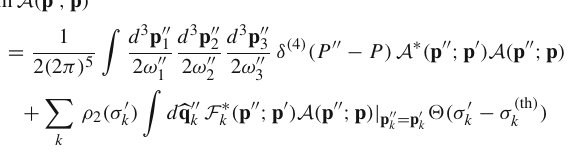
Fig. 4 Diagrammatic representation for the 2 → 2 disconnected amplitude unitarity relation in Eq. (6). The red vertical dashed line indicates the intermediate particles are put